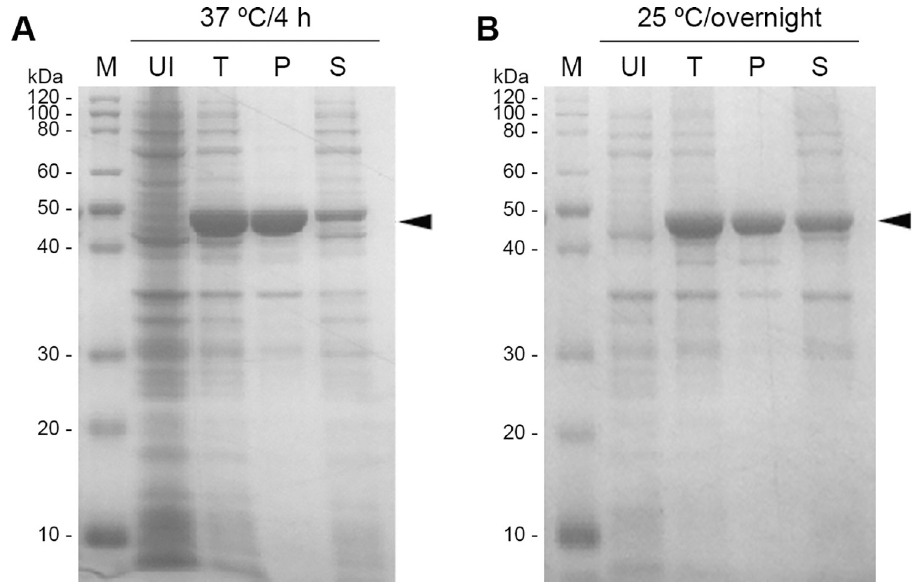
Fig 1. The recombinant expression of EcBAP in E . coli BL21(DE3) strain. (A) induced at 37˚C for 4 h; (B) induced at 25˚C overnight. M: Protein marker; UI: the total lysate of uninduced bacterial cells; T: the total lysate of induced bacterial cells; P: the pellet of ‘T’; S: the supernatant of ‘T’; Arrow-head indicates the recombinant EcBAP protein. The original gel images of this figure (A, B) are available in S1 File.